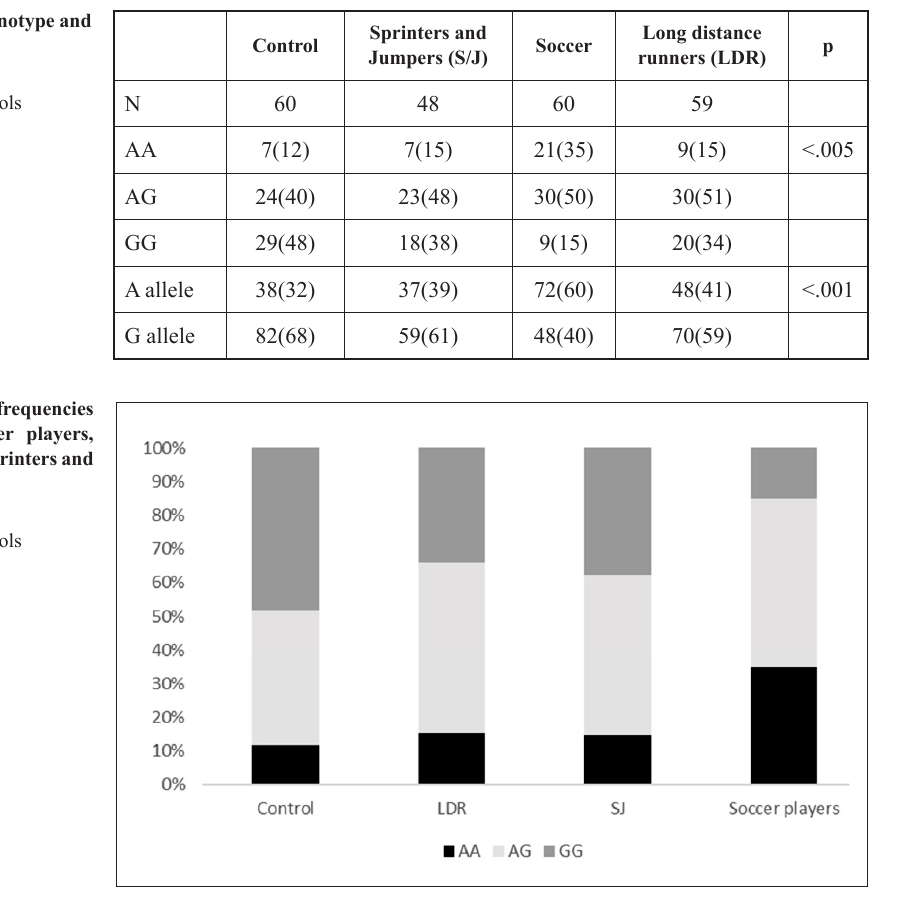
Table 3 . ACSL A/ G (rs6552828) Genotype and allele frequencies (%) χ 2 = 18.193, df = 2, p = 0.00011, genotype frequency, soccer vs. controls χ 2 = 9.711, df = 2, p = 0.00778,